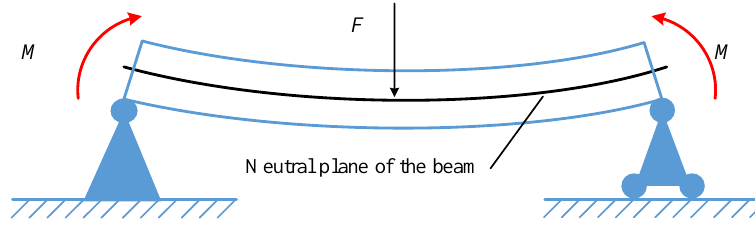
Figure 3. Schematic diagram of elastic deformation of the beam.